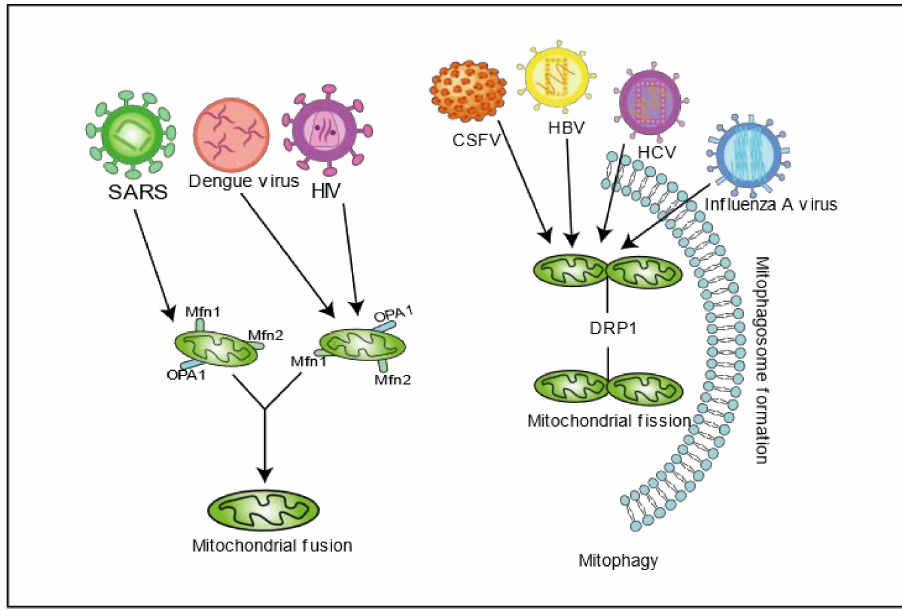
Figure 1. Viral infection disrupts mitochondrial dynamics. Different viruses affect mitochondrial dynamics through mito- chondrial fusion proteins (MFNs, OPA1) or fission proteins (DRP1) and induce mitophagy to clear damaged mitochondria to enhance cell survival and viral